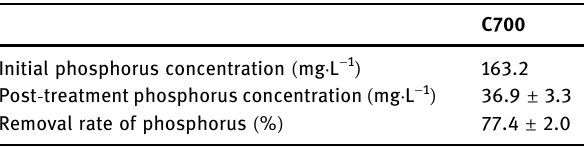
Table 5: E ff ect of biochar ( C700 ) on the treatment of real waste - water containing